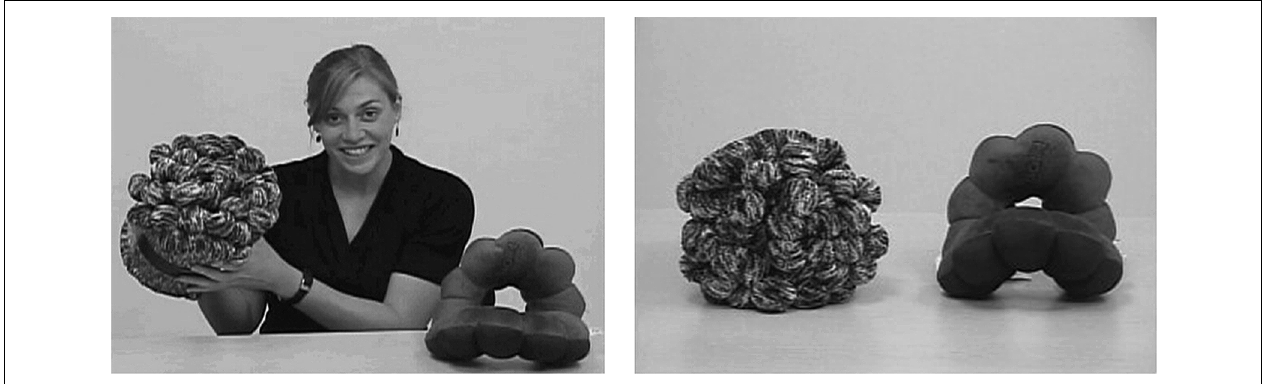
FIGURE 1 | Screen capture from the preliminary experiment. During familiarization (left), the speaker labeled the target object (e.g., “Hey, it’s a toma!”) three times. She then picked up and identified the distracter